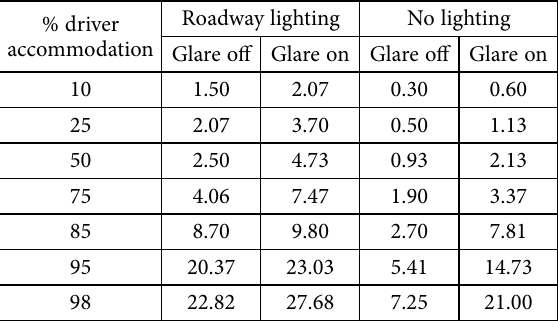
Table 1. Luminance requirements for guide sign